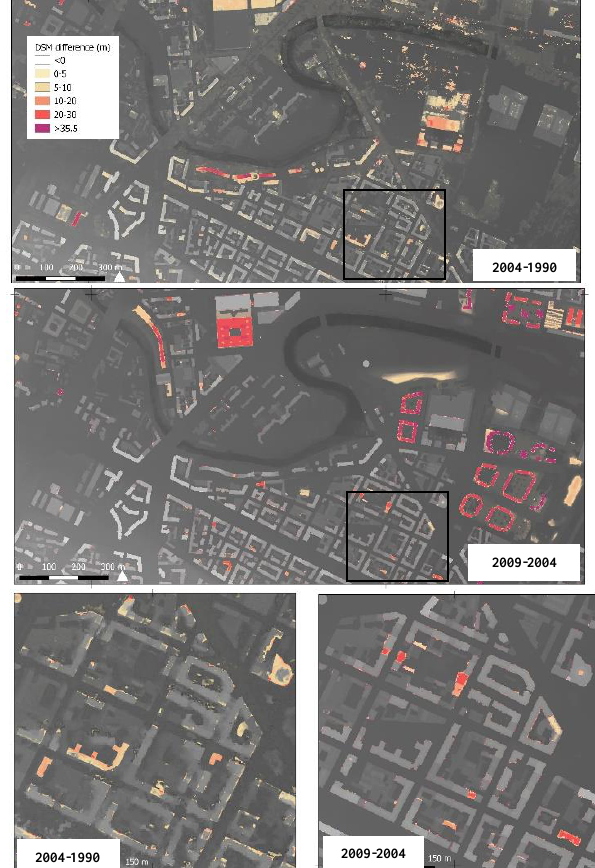
Figure 5. (top) The DSMD T2-T1 superimposed to 1990 DSM and (centre) DSMD T3-T2 superimposed to 2004 DSM. (bottom) Zoomed excerpts of the DSMD T2-T1 and DSMD